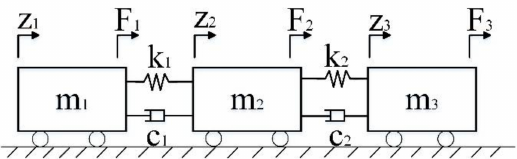
Figure 2. A three-degree-of-freedom